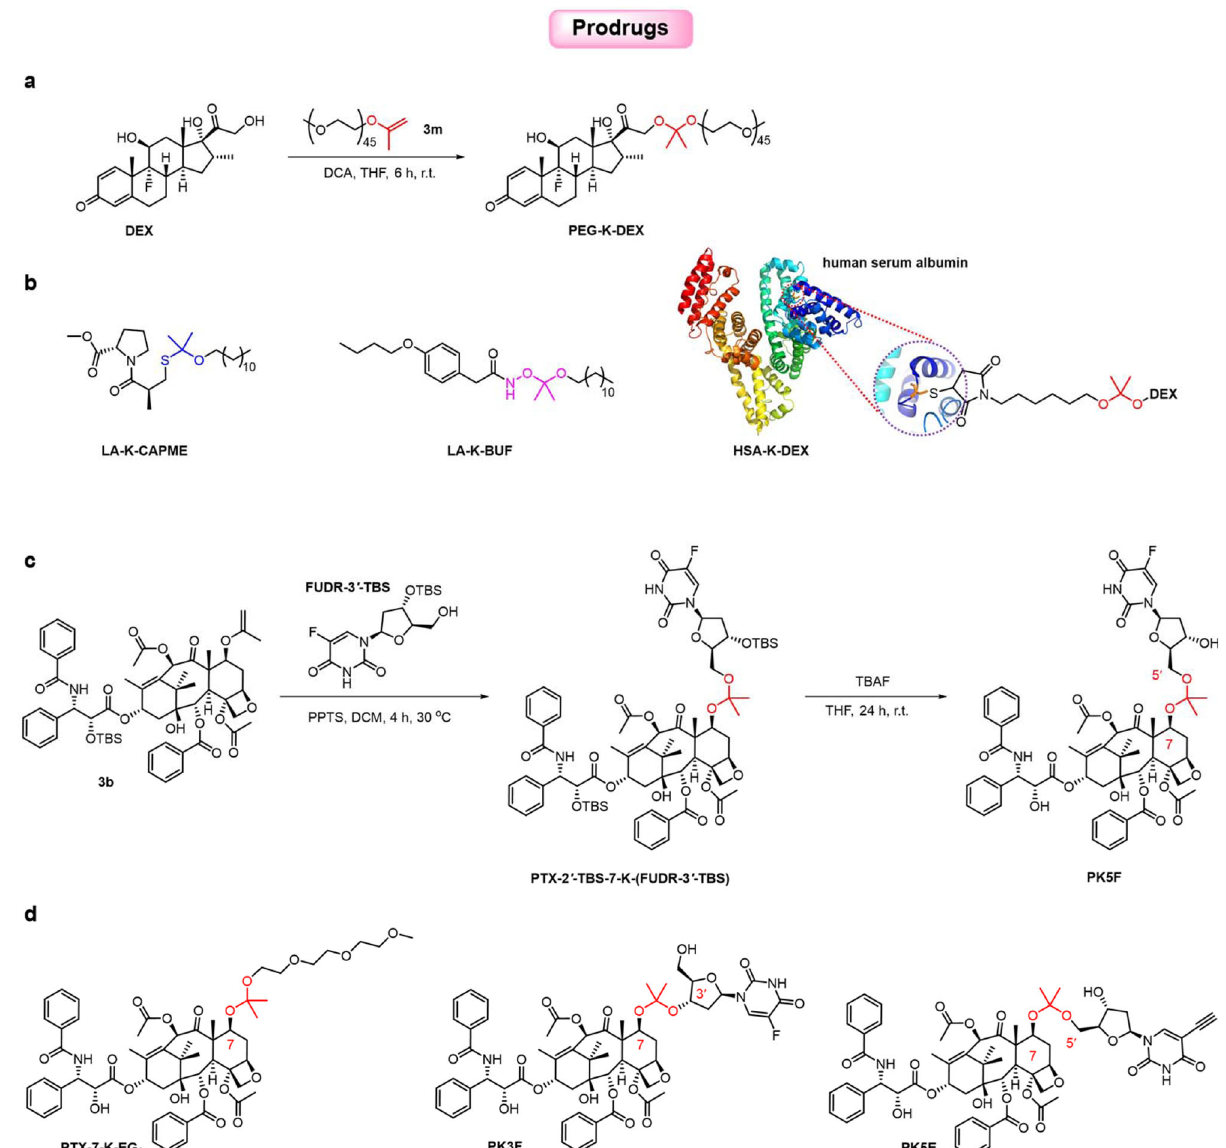
Fig. 4 Ketal-linked prodrugs. a synthesis of PEG-K-DEX; b structures of LA-K-CAPME, LA-K-BUF, and HSA-K-DEX; c synthesis of PK5F; d structures of PTX-7-K-EG 3 , PK3F, and